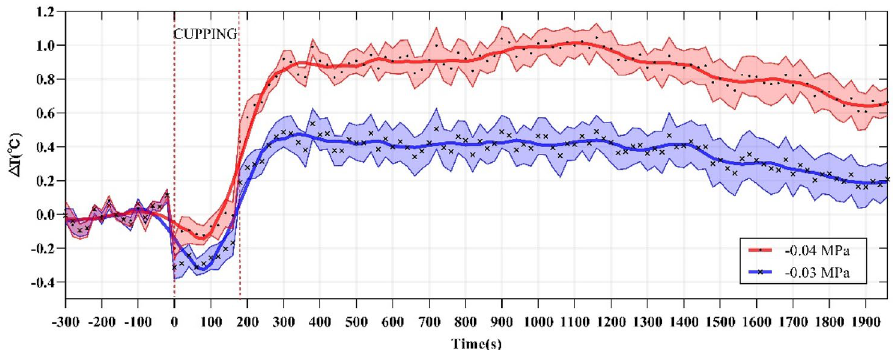
Figure 7. The average temperature variation of each time point with respect to the basal temperature during the test. The dots represent the average temperature difference, and the curves are obtained from these average temperature values using smooth spline fitting.